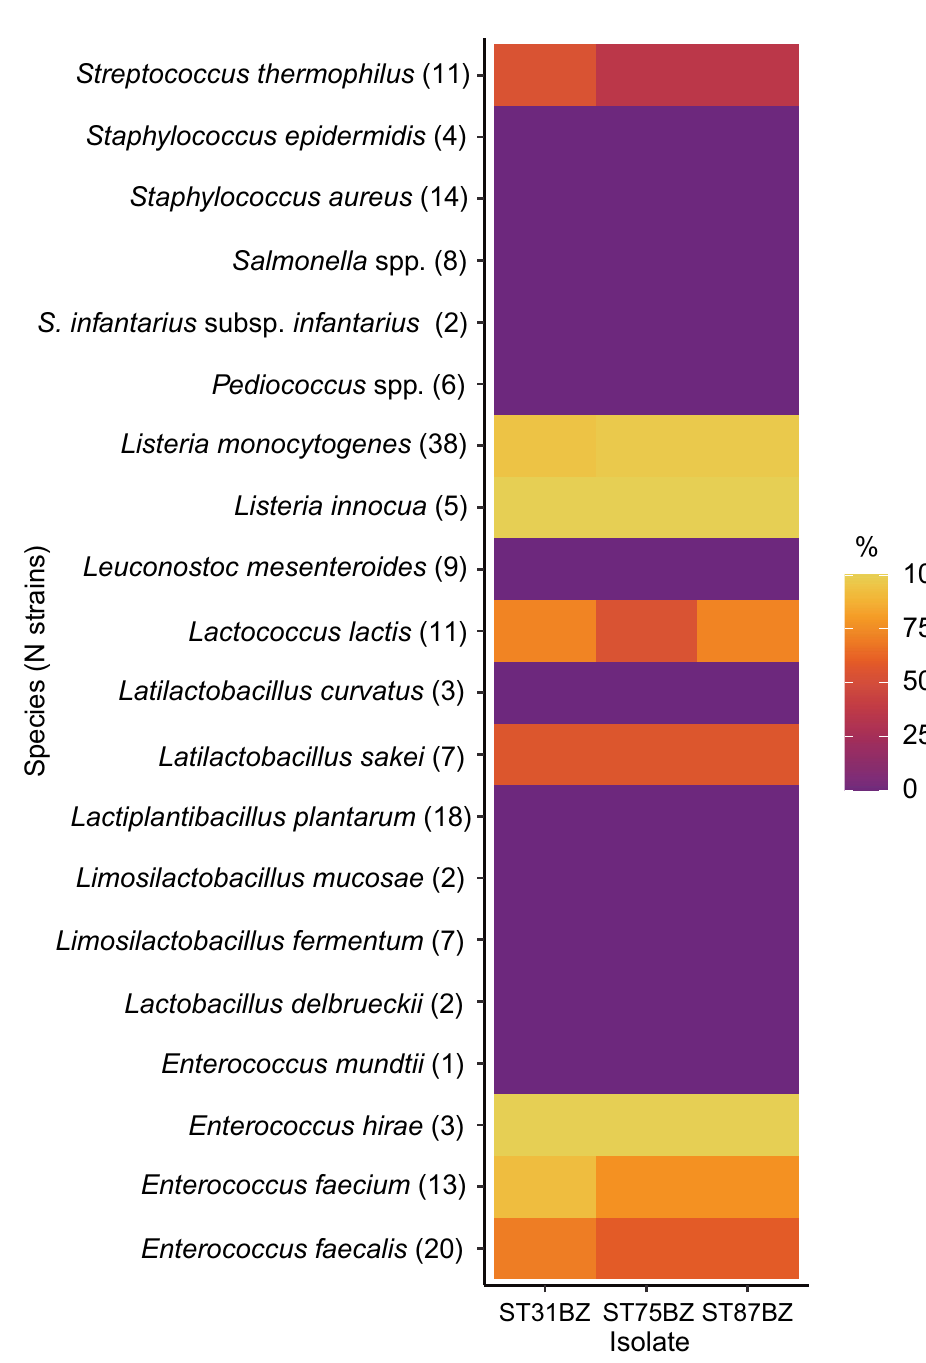
Figure 6. Bacterial susceptibility test results. The activity spectrum against tested strains is presented as a heatmap where colors indicate the proportion of susceptible strains from the total of tested strains (shown in parenthesis after the species